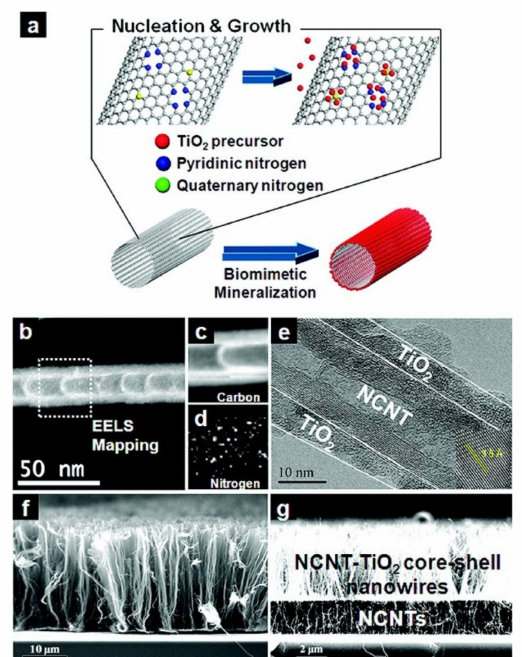
Figure 4. ( a ) Schematic illustration of biomimetic N-doped CNT (NCNT)/TiO 2 core/shell nanowire fabrication. Red, blue, and yellow colors indicate TiO 2 precursor, pyridinic N (NP), and quaternary N (NQ), respectively. N-doping sites act as nucleation sites. ( b ) ADF-STEM image of NCNT. EELS mapping shows ( c ) C and ( d ) N elements along NCNT. ( e ) TEM and (f ) SEM images of NCNT/TiO 2 core/shell nanowires. The inset shows the lattice distance of the anatase phase. ( g ) NCNT/TiO 2 core/shell (top) and bare NCNT (bottom) heteronanowires. Reprinted with permission from [78]. Copyright (2012) American Chemical